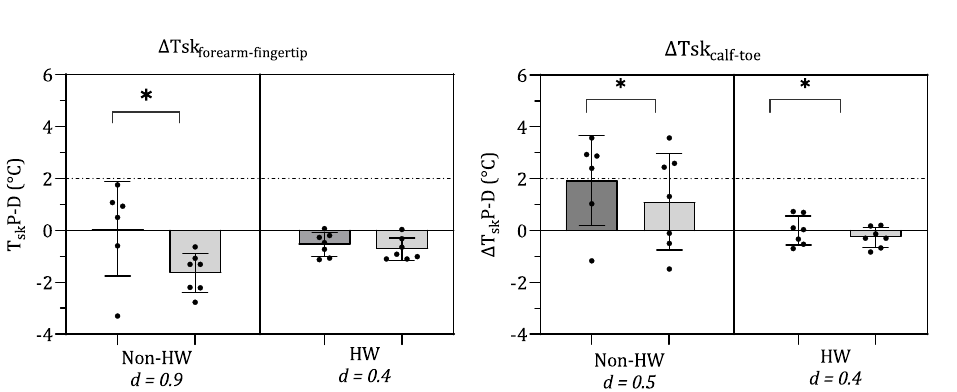
Figure 3. Mean ± SD and individual responses of skin blood flow responses (ΔTsk forearm-fingertip , ΔTsk calf-toe ) to 60° head-up tilt during the non-HW and HW. Significant differences between postures in each condition denoted with an asterisk (*). Dotted line indicates threshold for onset of vasodilation, solid line indicates threshold for onset of vasoconstriction. Cohen’s D effect sizes presented below ambient conditions, indicating the size of effect between supine and HUT in each ambient